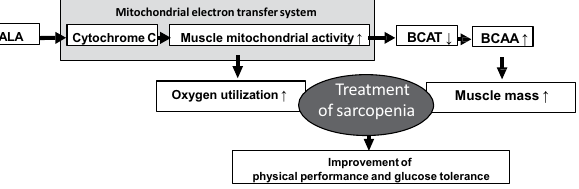
Figure 6. Schematic representation of the results of the present study. We found that ALA improved physical performance and glucose tolerance by increasing muscle mitochondria and promoting oxygen utilization as well as by increasing BCAAs and muscle mass through suppression of BCATs expression. 5-ALA, 5-aminolevulinic acid; BCAT, branched-chain amino acid aminotransferase; BCAA, branched chain amino